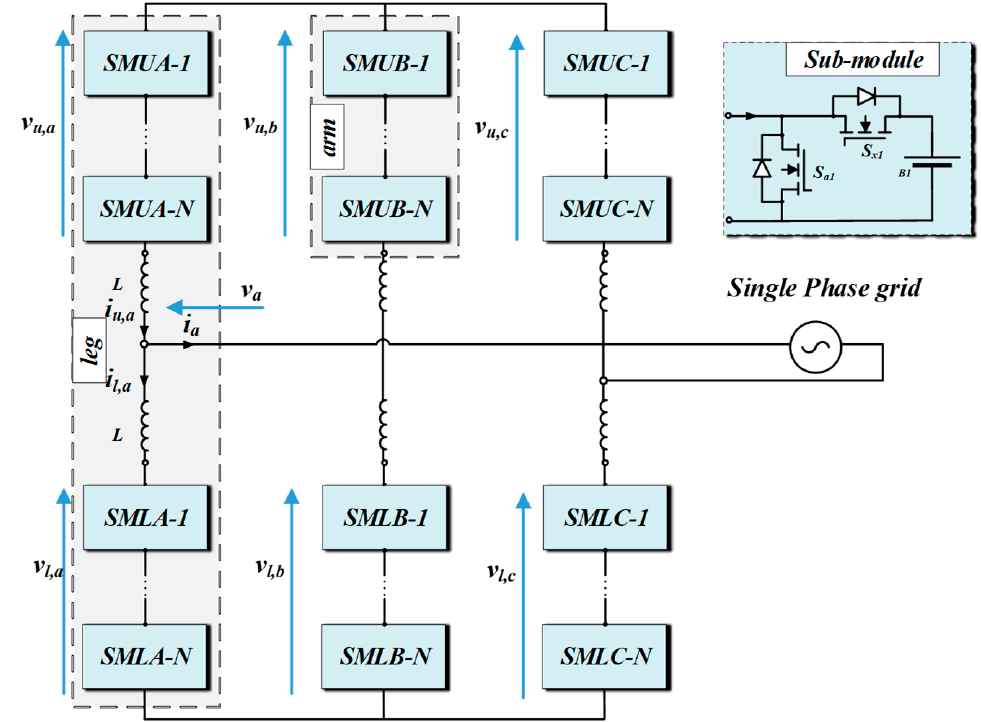
Figure 1. Main MMC-EB integrated charging from single-phase source configuration.